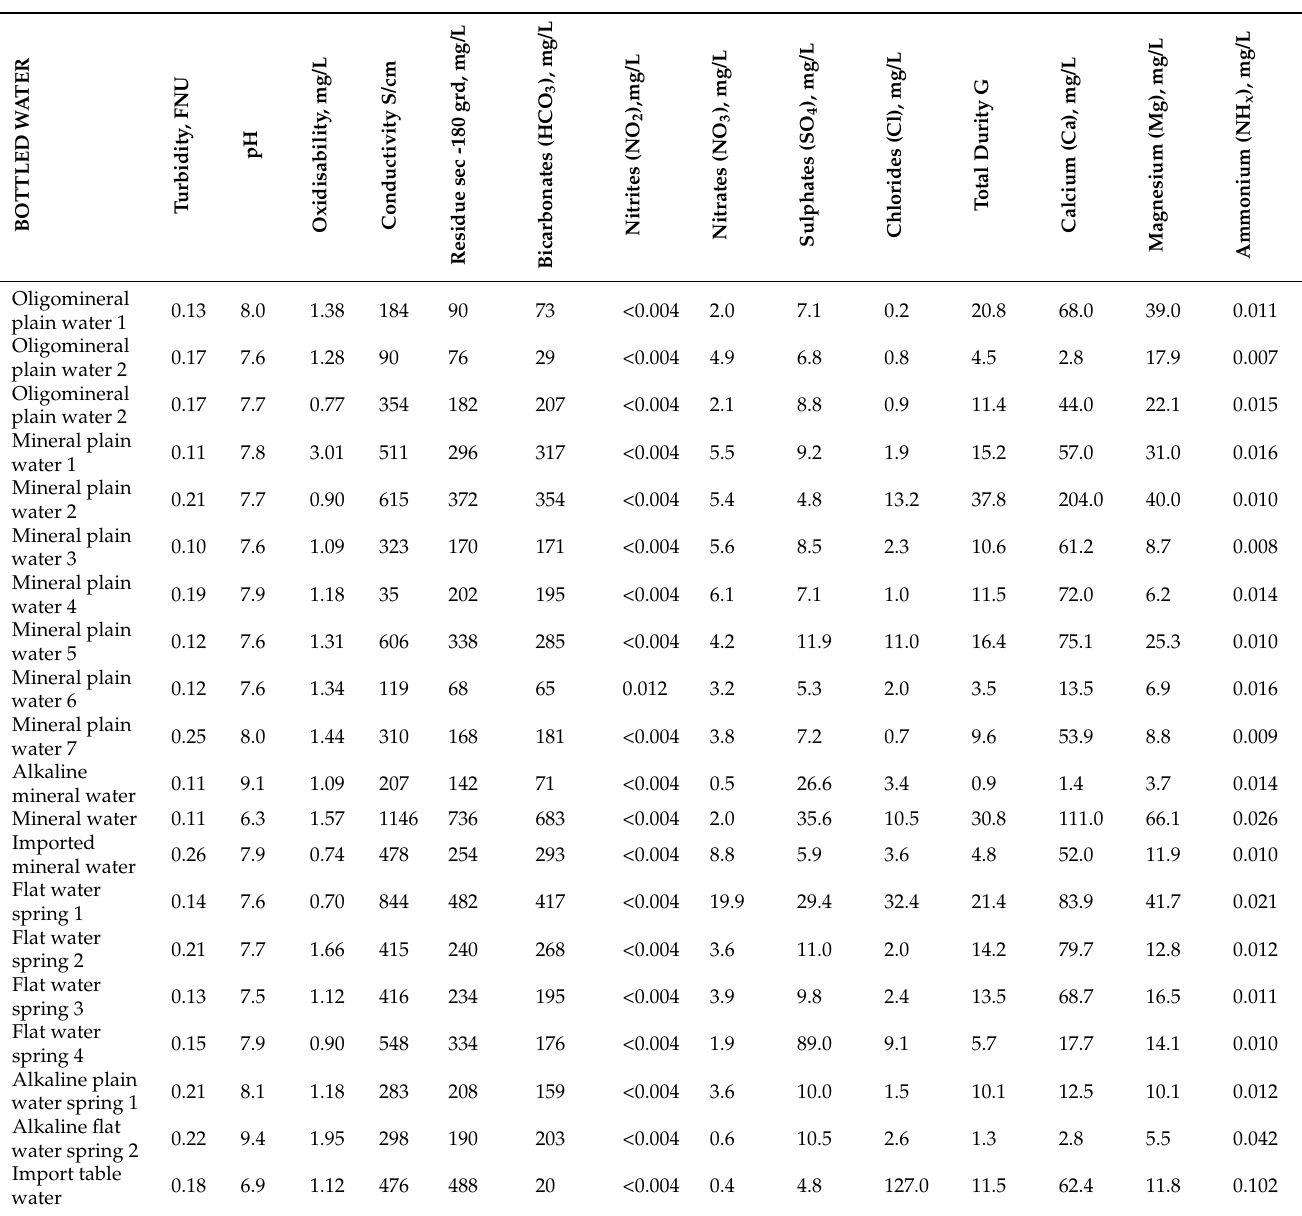
Table 1. Physico-chemical parameters for bottled water.